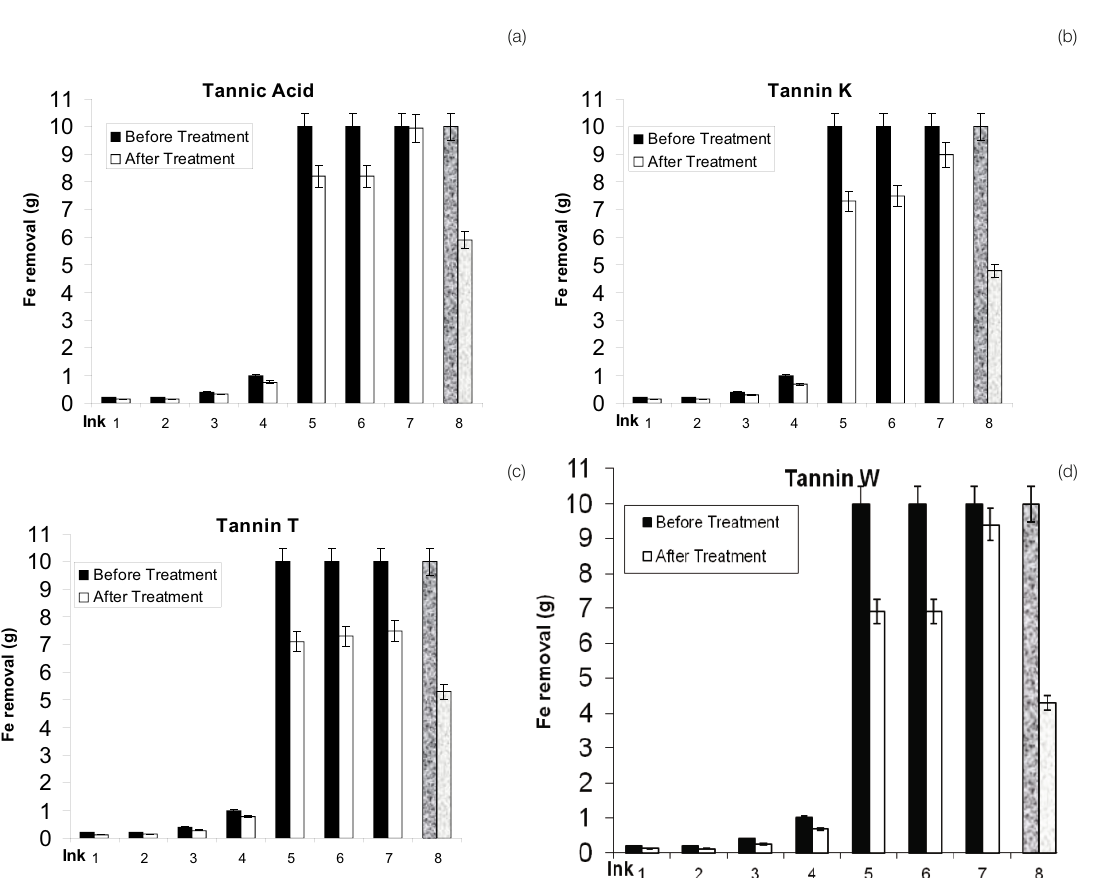
Figure 2. Iron removal from naturally aged iron-gall inks after treatment with calcium phytate solution. (Bars represented as Ink 8 correspond to percent copper removal from Ink 7). Inks prepared using: (a) Tannic Acid; (b) Tannin K; (c) Tannin T; and, (d) Tannin